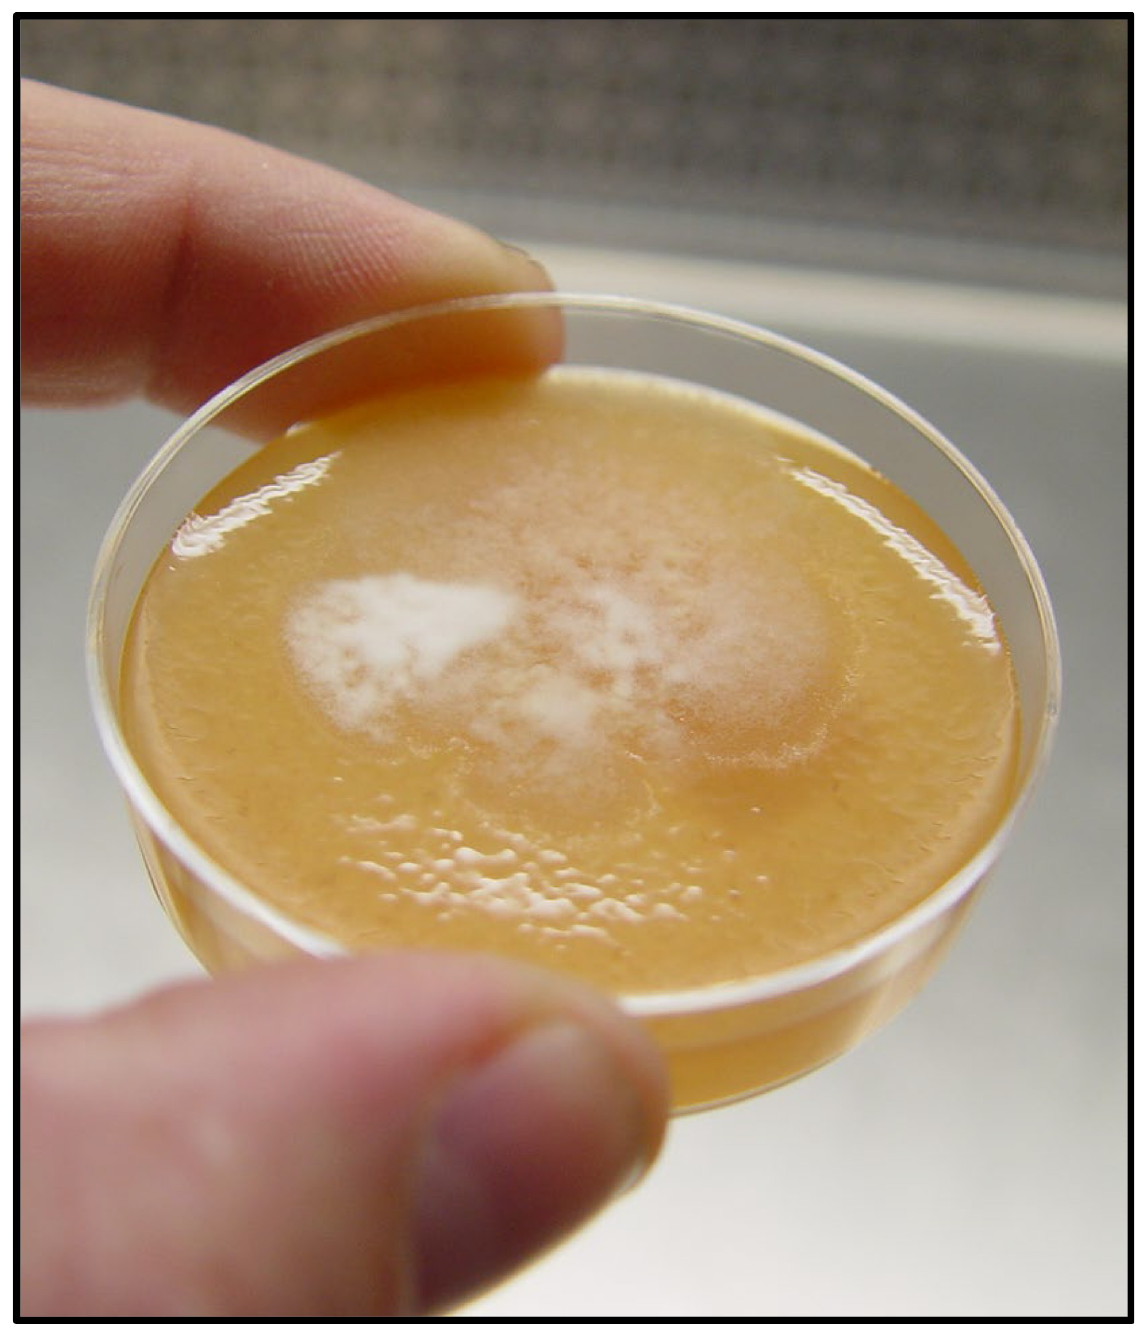
Fig 1. Example of sectoring in a single-zoospore derived isolate of Phytophthora capsici used in this study. agar media indicates allele frequencies can be a poor measure of a chromosome’s copy number (Figs 5–7 and S1–S4 Figs). The chromosome-specific allele frequencies and coverage plots for 33 isolates of P . capsici (or near relatives such as P . tropicalis and the provisional species ‘P. subnubulis’) indicate at least 20% of these isolates carry heterogenous heterozygous allele fre- quencies and/or intra-genomic variation in chromosome copy number (S1 Table, S1 and S2